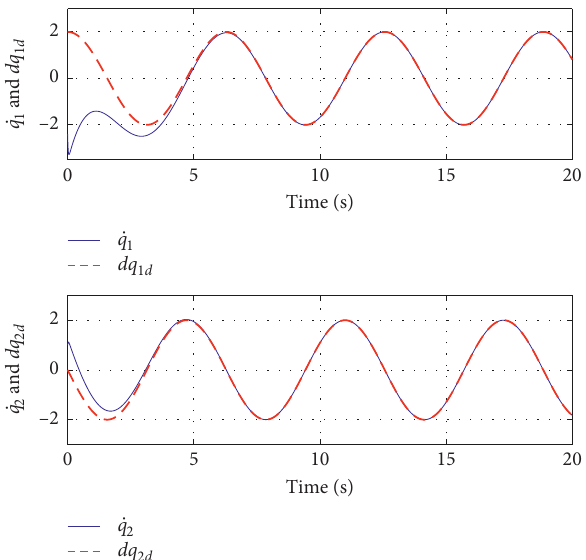
Figure 4: Velocity tracking of joint 1 and joint 2 of SCARA.